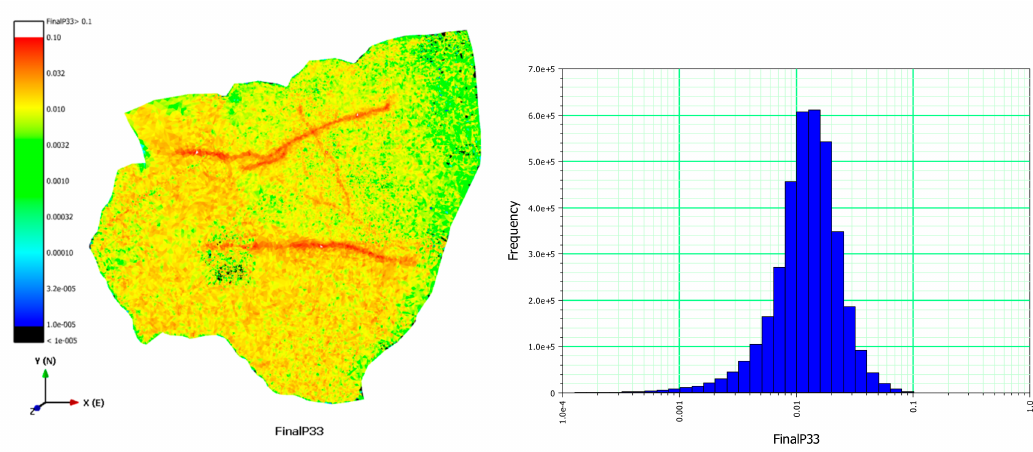
Figure 14. Upscaled fracture porosity